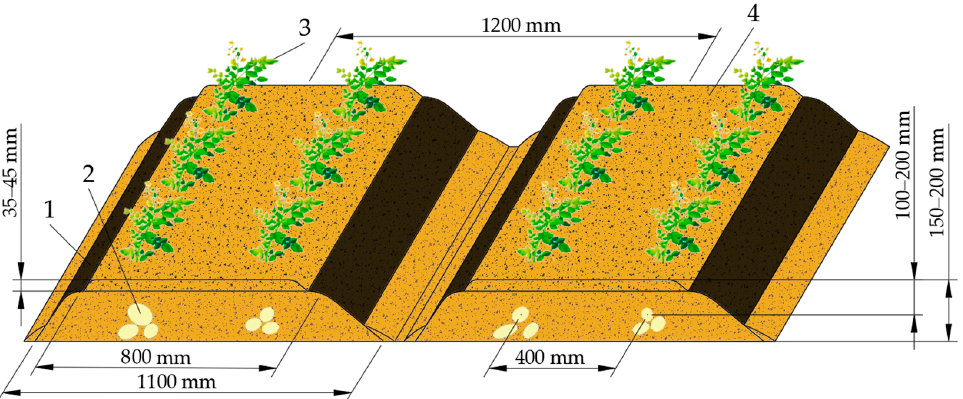
Figure 15. Large ridges with two rows per ridge and with covering soil on top of the plastic fi lm mulch: 1—black plastic fi lm; 2—potato; 3—potato seedling; 4—covering soil. mulch: 1—black plastic film; 2—potato; 3—potato seedling; 4—covering